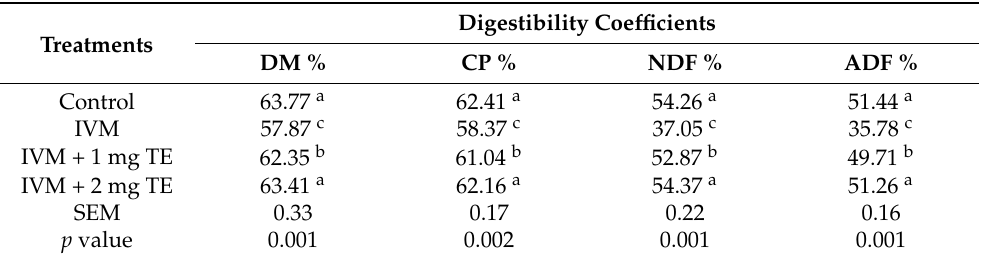
Table 3. The effect of combining of Ivermectin injection with turmeric extract supplementation on growing rabbit digestibility